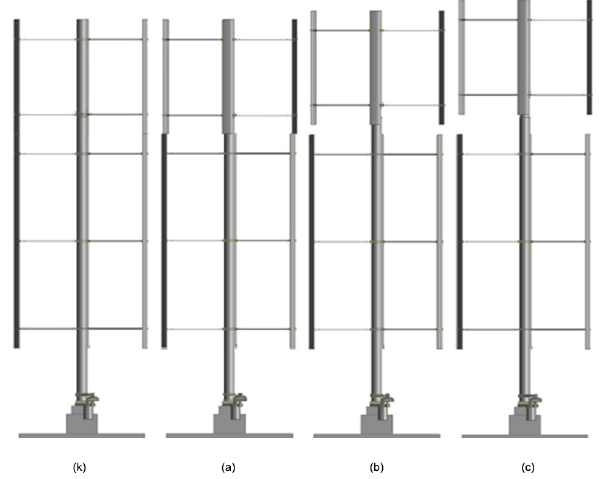
Figure 2. Chosen VAWT configurations tested in the wind tunnel.